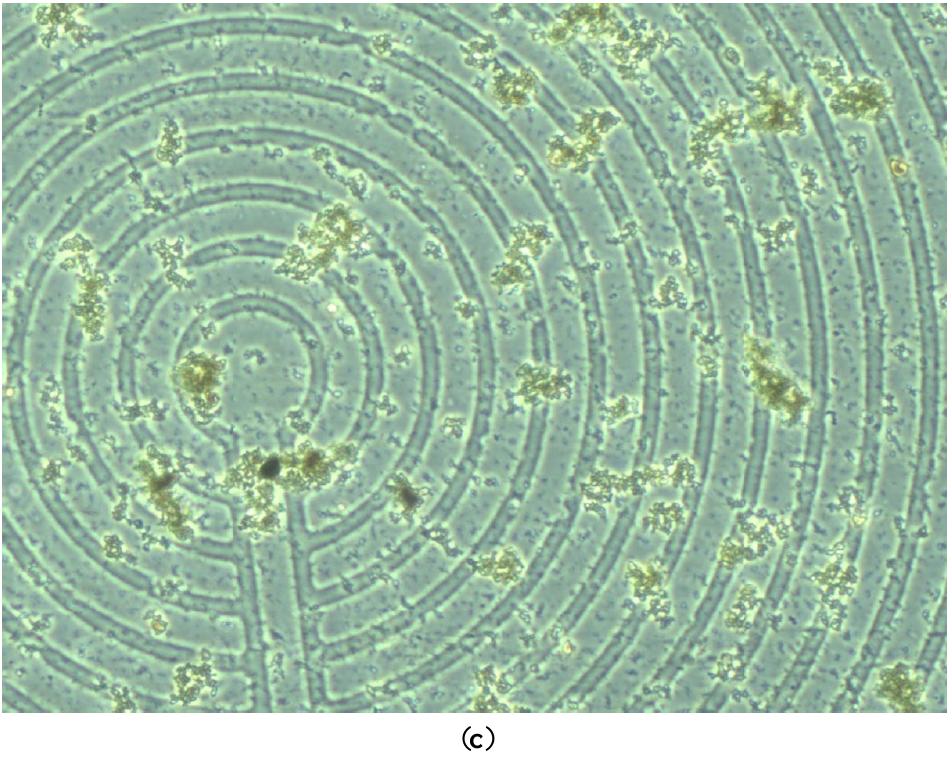
Figure 10. Experimental results: aggregation of nanoparticles above the microcoil. Generating a magnetic field ( a ) before applying an electromagnetic field; ( b ) immediately after applying electromagnetic field and ( c ) 10 s after applying electromagnetic